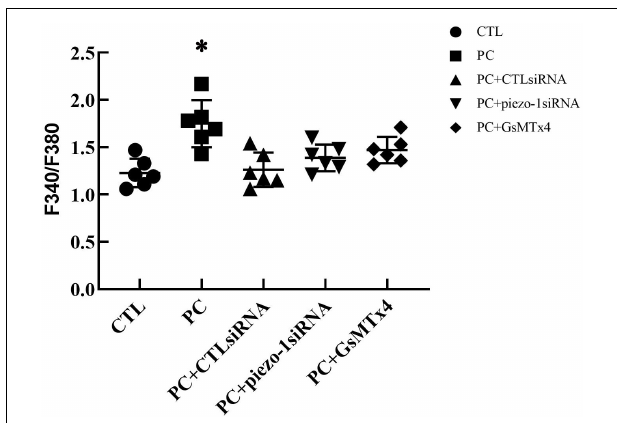
FIGURE 5 | Analysis of [Ca 2 + ] i in HSAECs. Cells propagated under normal atmospheric pressure were set as controls (CTL, the baseline). HSAECs exposed to 10 cmH 2 O of pressure for 12 h were marked as the ‘pressure culture’ (PC) group. Data are expressed in a scatter diagram. Bars represent the mean and SD. Differences between groups were analysed using one-way ANOVA, followed by Bonferroni’s test. ∗ P < 0.05 vs. ‘PC + piezo-1 siRNA’ or ‘PC + GsMTx4.’